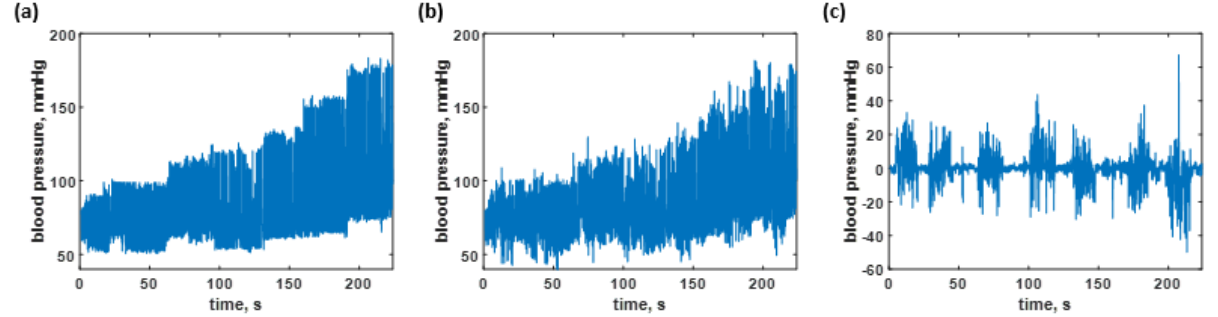
Figure 10. Shows the blood pressure levels in ( a ) the test dataset; ( b ) B.P. prediction using the trained network; and ( c ) test data error calculated using the data in Figure 7a,b.